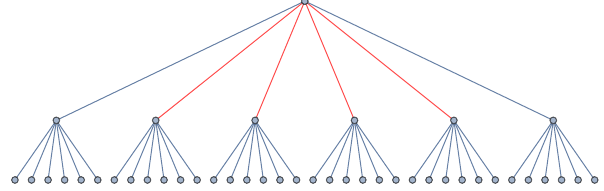
FIG. 4. A tree of depth d ¼ 2 with k ¼ 6 arms. Blue edges represent entanglement created by pumping an emitter, while red edges represent entanglement created with a CZ gate between an emitter and another emitter or